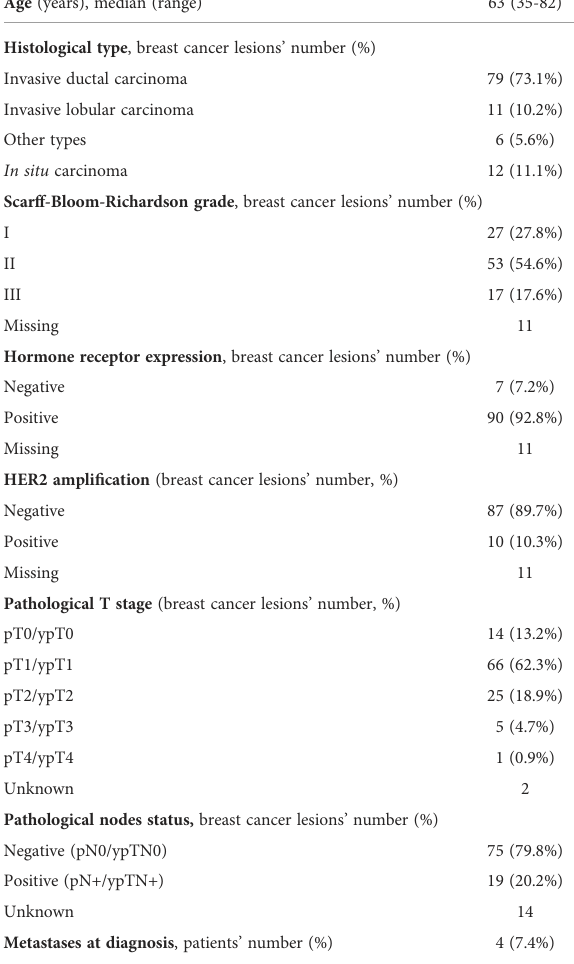
TABLE 1 Characteristics of patients (n=54) and breast cancer lesions